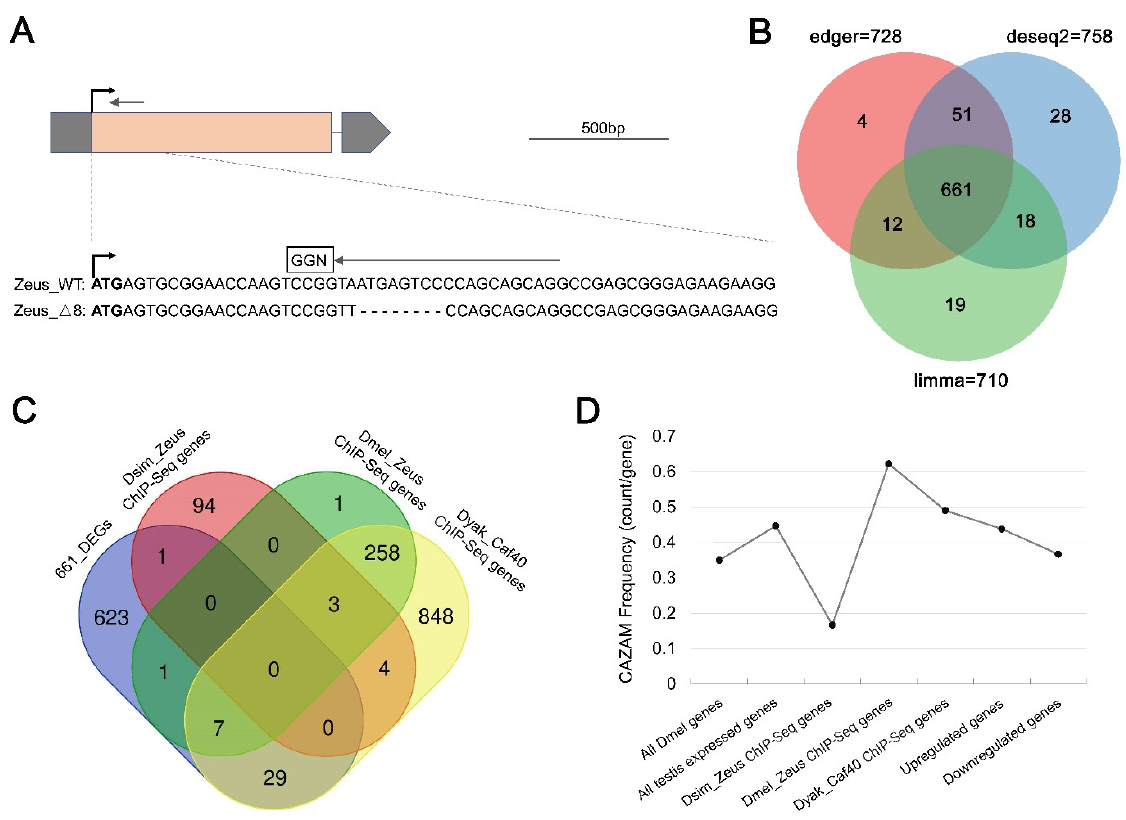
Figure 5. Zeus regulated DEGs expression not by direct CAZAM Motif binding pattern. ( A ) Zeus_KO CRISPR mutant creation. Small gray arrow indicates position of small-guide RNA. Peach section corresponds to the one and only exon. Gray sections correspond to the 5 ′ and 3 ′ UTR. ( B ) Venn Diagram of DEGs identified in three differential expression anal- ysis software: EdgeR, DEseq2 and Limma (see Supplementary Materials and Methods). ( C ) Venn Diagram among the 661 DEGs, 102 Dsim_Zeus ChIP-Seq genes, 270 Dmel_Zeus ChIP-Seq genes, and 1149 Dyak_Caf40 ChIP-Seq genes. ( D ) CA- ZAM frequency in several gene groups: all Dmel genes refer to all annotated 17,874 D. melanogaster genes; all testis ex- pressed genes refers to testes expressed 11,491 genes by RNA-Seq in this study; 331 upregulated genes and 330 downreg- ulated genes constitute the 661 DEGs in Zeus_KO testes by RNA-Seq in this study.